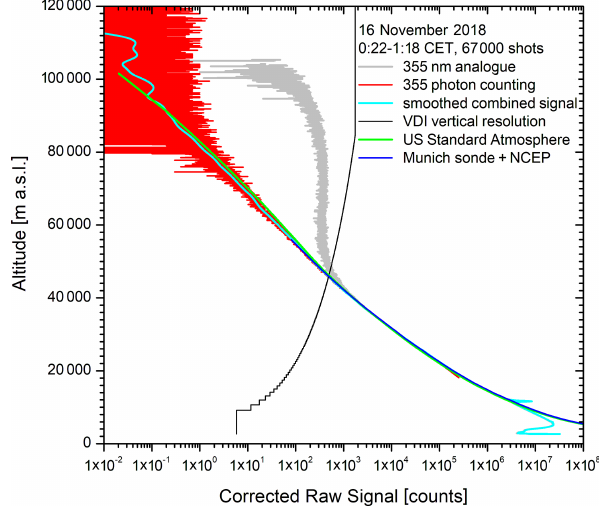
Figure 17. 355nm backscatter coefficients for a 355nm measure- ment on 16 November 2018 together with the smoothed combined analogue plus photon-counting signal; the VDI vertical resolution of the smoothing procedure is given in metres. Simulated backscat- ter signals calculated from the U.S. Standard Atmosphere (1976) and a combined radiosonde and NCEP profile are included for com-